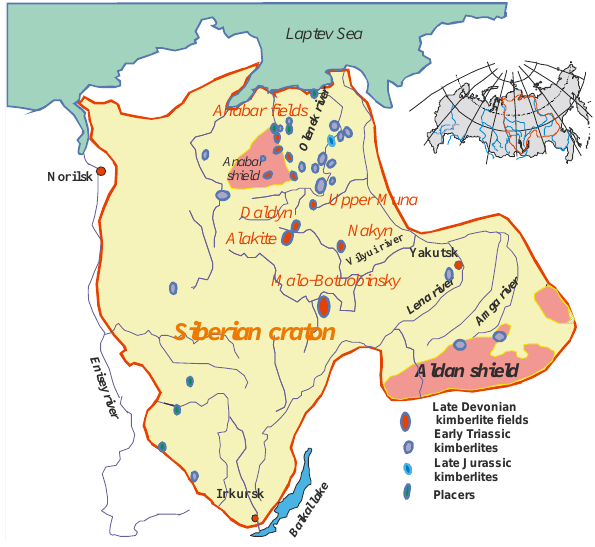
Figure 1. Scheme of the location of kimberlite fields in the Siberian platform.